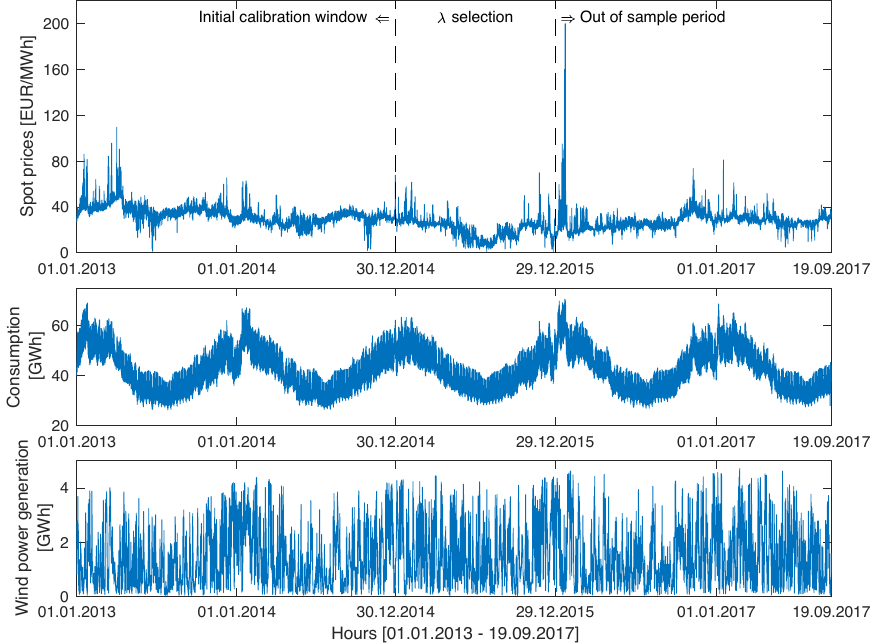
Figure 1. Nord Pool hourly system prices (top), hourly consumption prognosis (middle) and hourly wind power prognosis for Denmark (bottom) for the period 1 January 2013 to 19 September 2017. The vertical dashed lines mark the beginning of the 364-day period for selecting λ s for LASSO and the beginning of the 631-day long out-of-sample test period.